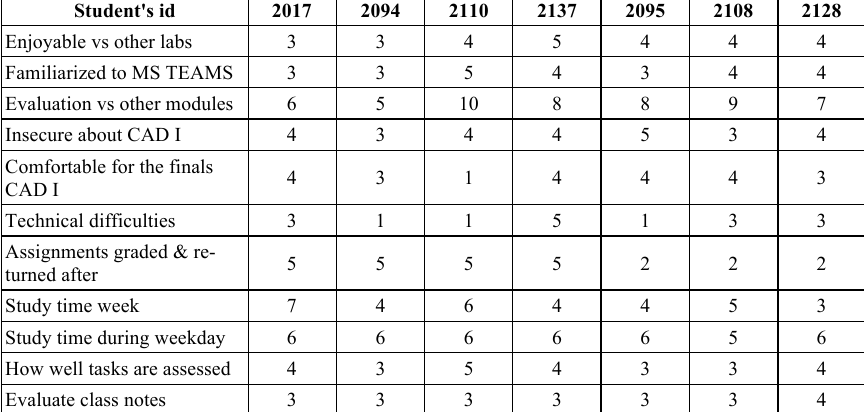
Table 3. Students with higher prediction